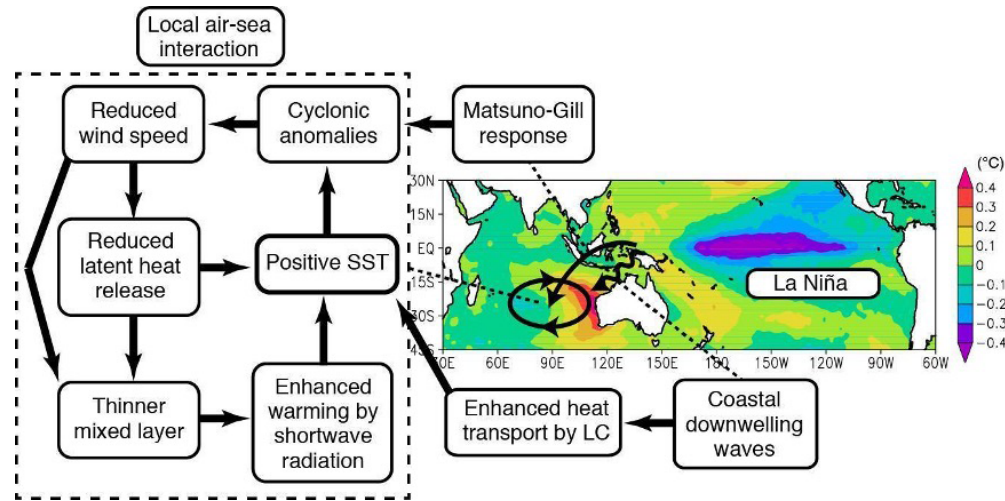
Figure 18. Schematic diagram illustrating generation mechanisms (i.e. local air–sea interaction, atmospheric teleconnection, and oceanic wave propagation) of the Ningaloo Niño. SST anomalies are regressed against the Ningaloo Niño Index to illustrate typical SST anomalies associated with the